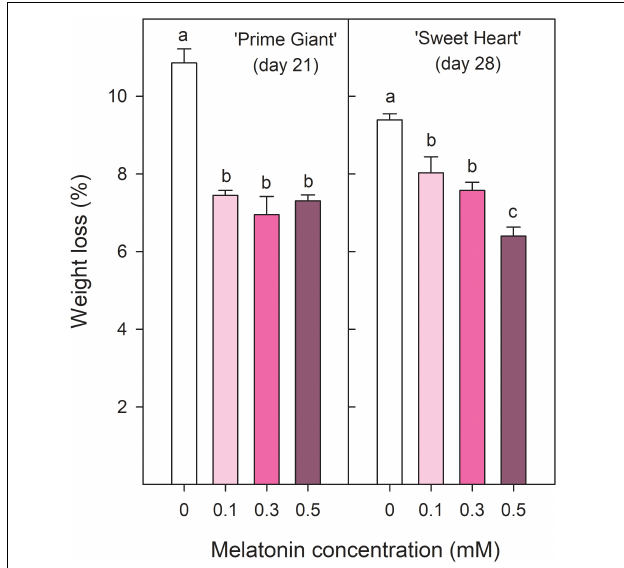
FIGURE 1 | Weight losses for ‘Prime Giant’ and ‘Sweet Heart’ cultivars after 21 and 28 days of storage at 2 ◦ C, respectively, as affected by melatonin pre-harvest treatments. Data are the mean ± SE of three replicates of 20 fruits. Different letters show significant differences ( p < 0.05) among treatments for each